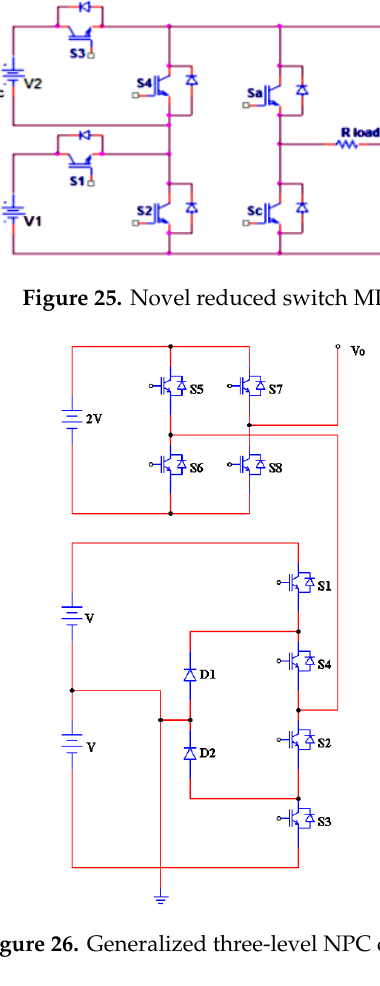
Figure 26. Generalized three-level NPC circuit.